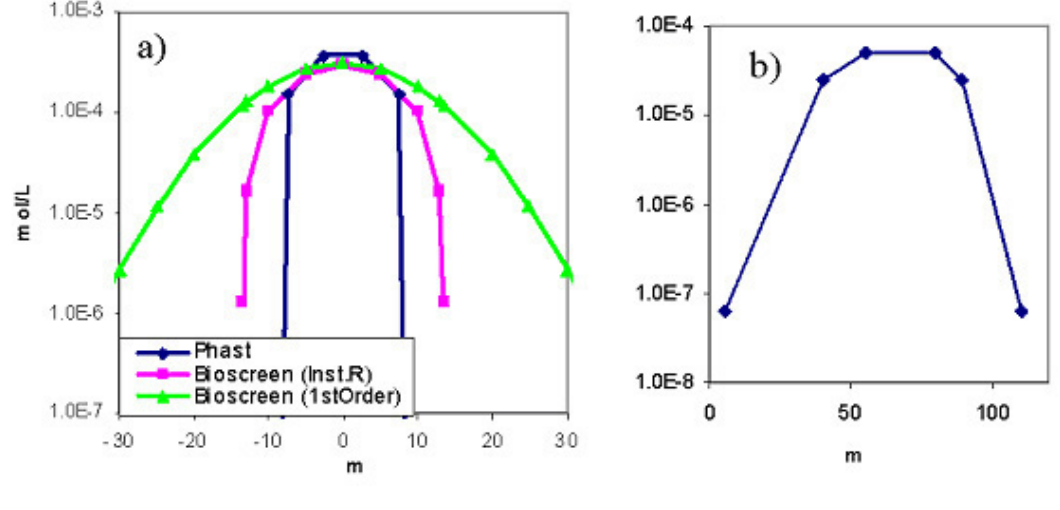
FIGURE 3. (A) BIOSCREEN and PHAST simulations of plume transverse profile at 50-m distance from the source, hydrodynamic parameters being equal to the one used in Fig. 2, t = 5 years, Co = 13 mg/l (1 mmol/l of CH compound) in a 10-m wide source. (B) An example of a transverse profile in a BTEX plume: the case of